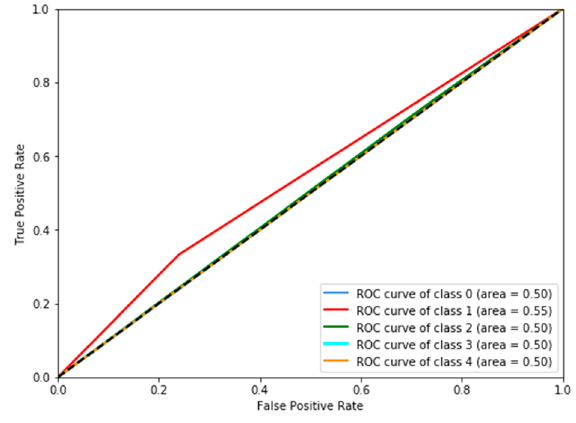
Figure 9. Per-class AUC of state-of-the-art.